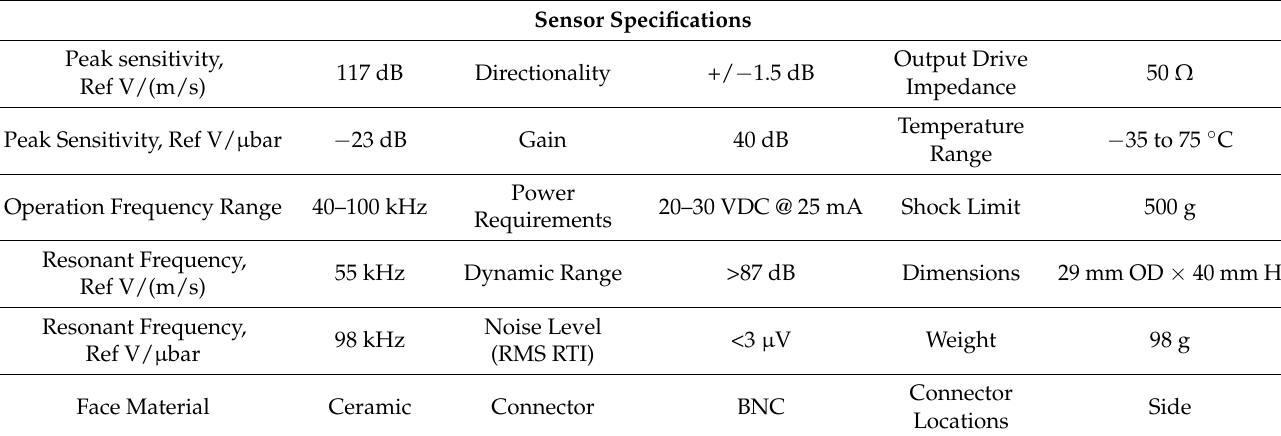
Figure 6. Hole expansion test using AE sensor. Table 2. R6I-AST